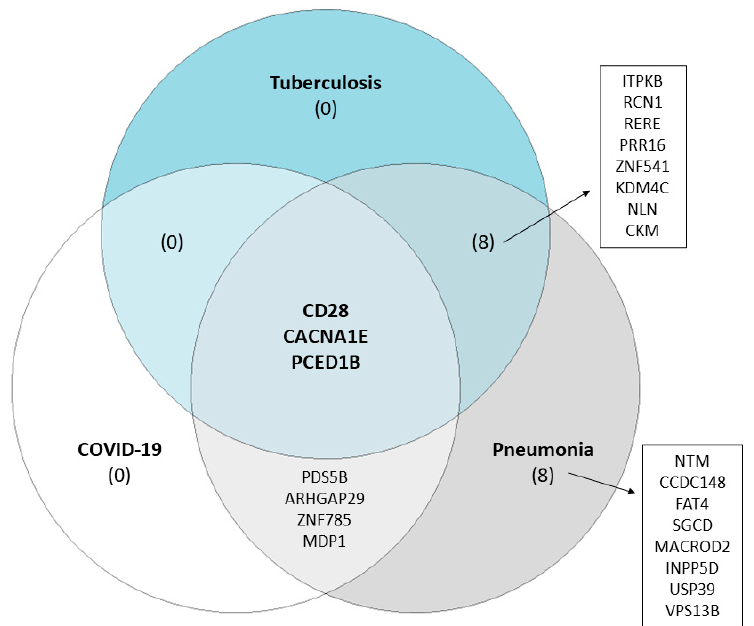
Figure 2. Validation of GWAS candidate loci using differentially expressed genes (FDR < 0.05) from publicly available RNA-seq studies (GEO accession IDs: pneumonia GSE196399, tuberculosis GSE94438 and COVID-19 GSE223885).